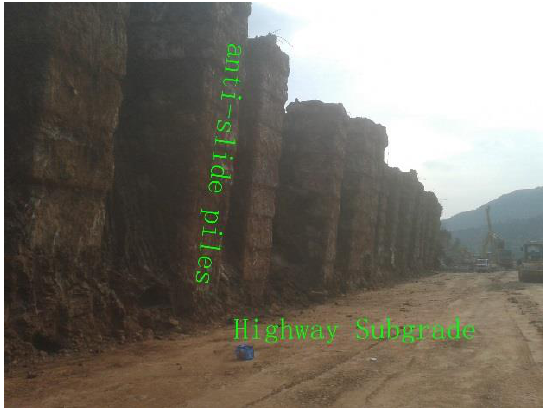
Figure 8. Anti-slide pile.